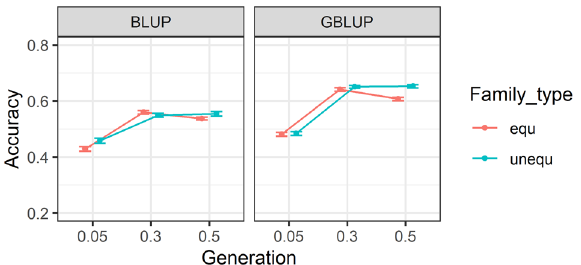
Figure 3. Accuracy of (genomic) estimated breeding values (G)EBV within three heritabilities. The accuracies are provided for equal and unequal family contributions. Accuracies in BLUP were averaged over five generations and ten replicates, while for GBLUP are estimated by averaging correlations over five generations, ten replicates, three marker densities and four genotypic error rates. Standard errors of accuracies are shown as error